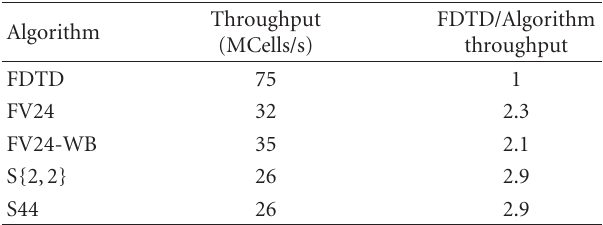
Table 5: Comparison of CPU codes’ throughputs for the various FDTD